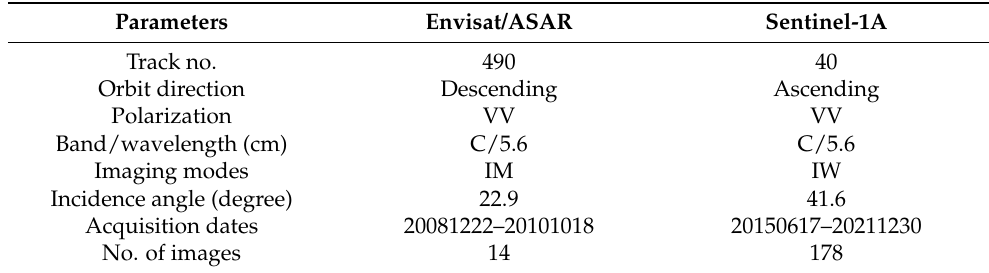
Table 1. The parameters of SAR datasets used in this